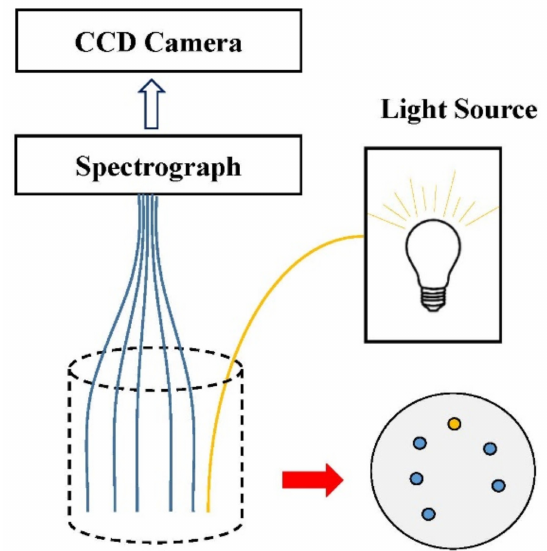
Figure 4. The configuration of the ring arrays based on an imaging spectrograph. (CCD = charge- coupled device).